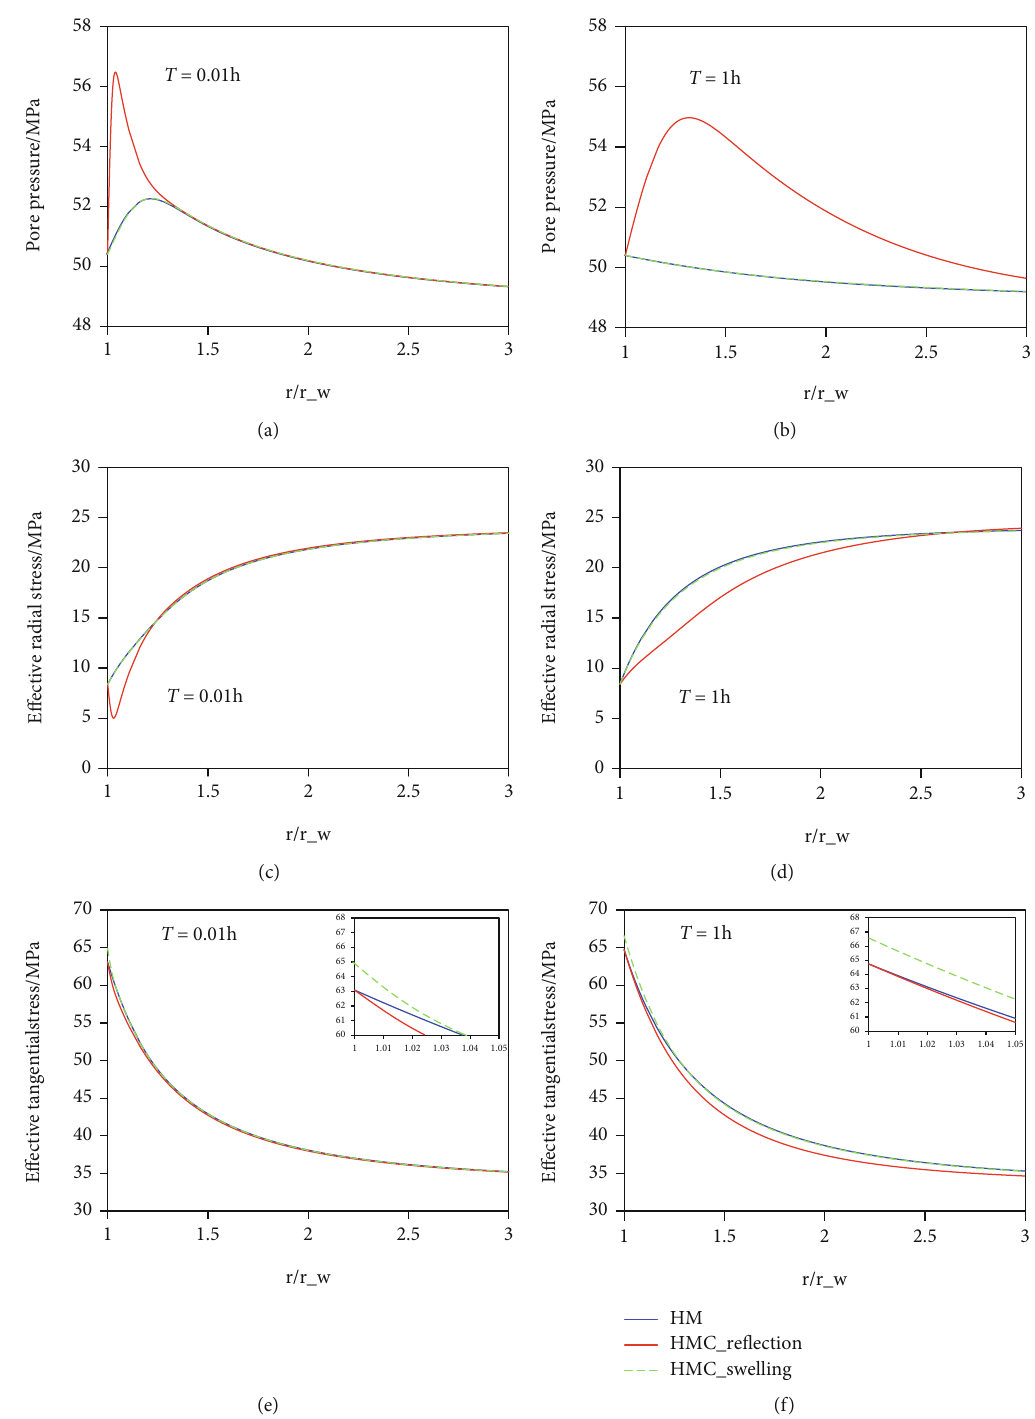
Figure 13: Pore pressure distribution around wellbore (a) 0.01h and (b) 1 h after drilling; e ff ective radial stress distribution around wellbore (c) 0.01h and (d) 1h after drilling; and e ff ective tangential stress distribution around wellbore (e) 0.01h and (f) 1h after